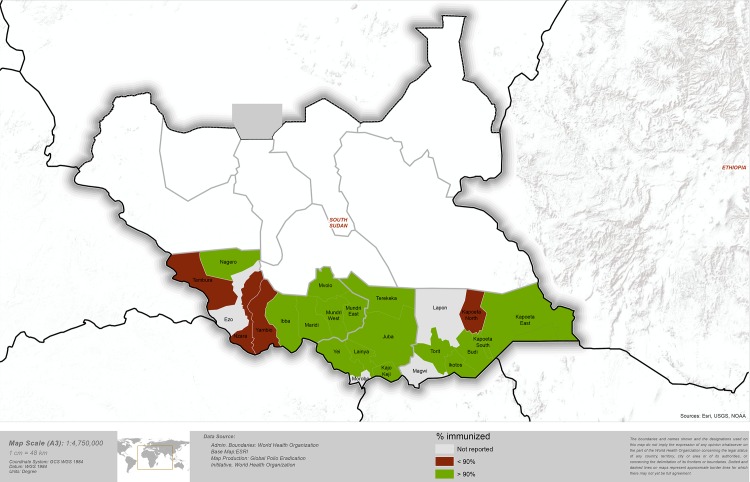
Map of South Sudan with colour representing reported post-campaign polio immunisation coverage.Red Colour < 90% reported polio immunisation coverage, Green Colour > 90% reported polio immunisation coverage.